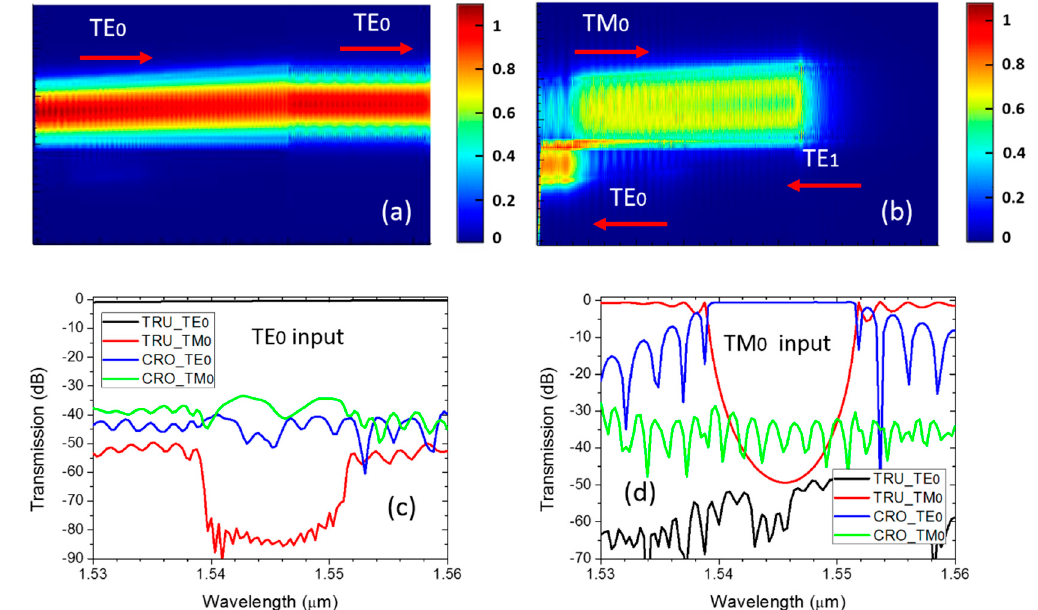
Figure 9. The light propagation profiles (electric field intensity | E | ) for the PSR when ( a ) TE 0 mode and ( b ) TM 0 mode are launched at wavelength of 1.546 μ m. The simulated transmission spectra of the proposed PSR when ( c ) TE 0 mode and ( d ) TM 0 mode are launched.